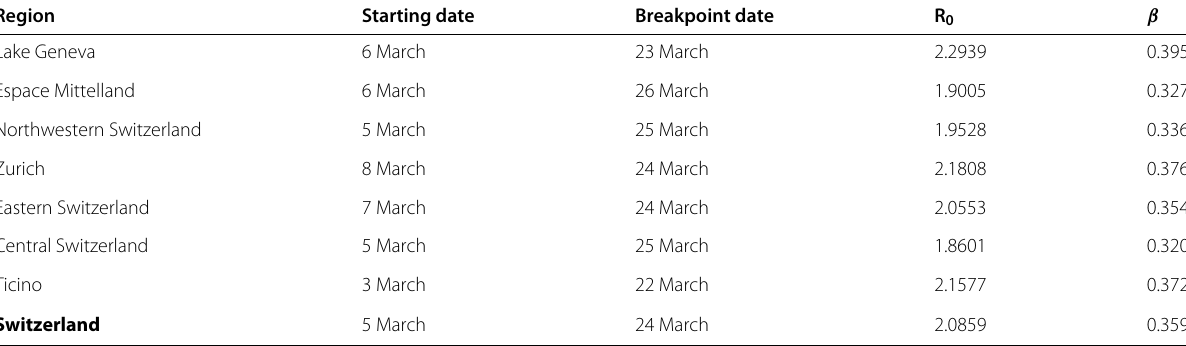
Table 4 Estimates of R 0 during the early phase of the epidemic Region Starting